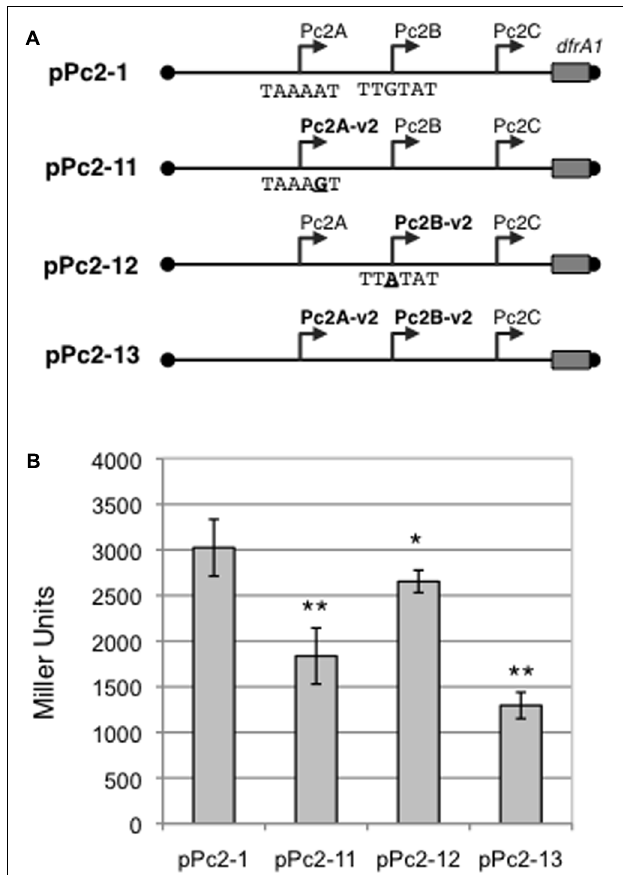
FIGURE 5 | Strength of the Pc2A and Pc2B promoter variants. (A) Schematic representation of Pc- lacZ translational fusions with the entire attI2 sites carrying combinations of promoters Pc2A, Pc2B, Pc2A-v2 and Pc2B-v2. Sequences of the -10 or -35 elements of, respectively, Pc2A and Pc2B promoters are written. Boundaries of the cloned fragment are indicated by black dots. The cloned portion of the dfrA1 coding sequence is indicated by a rectangle. Broken arrows represent the Pc promoters. (B) The contribution of the Pc2A and Pc2B variants to gene cassette expression was estimated by measuring β -galactosidase activity from the various constructs. At least five independent assays were performed for each construct. Error bars indicate the standard deviation. P -values (ANOVA and HSD Tukey’s test) for the comparison with pPc2-1 are indicated: ∗ p < 0.05, ∗∗ p <